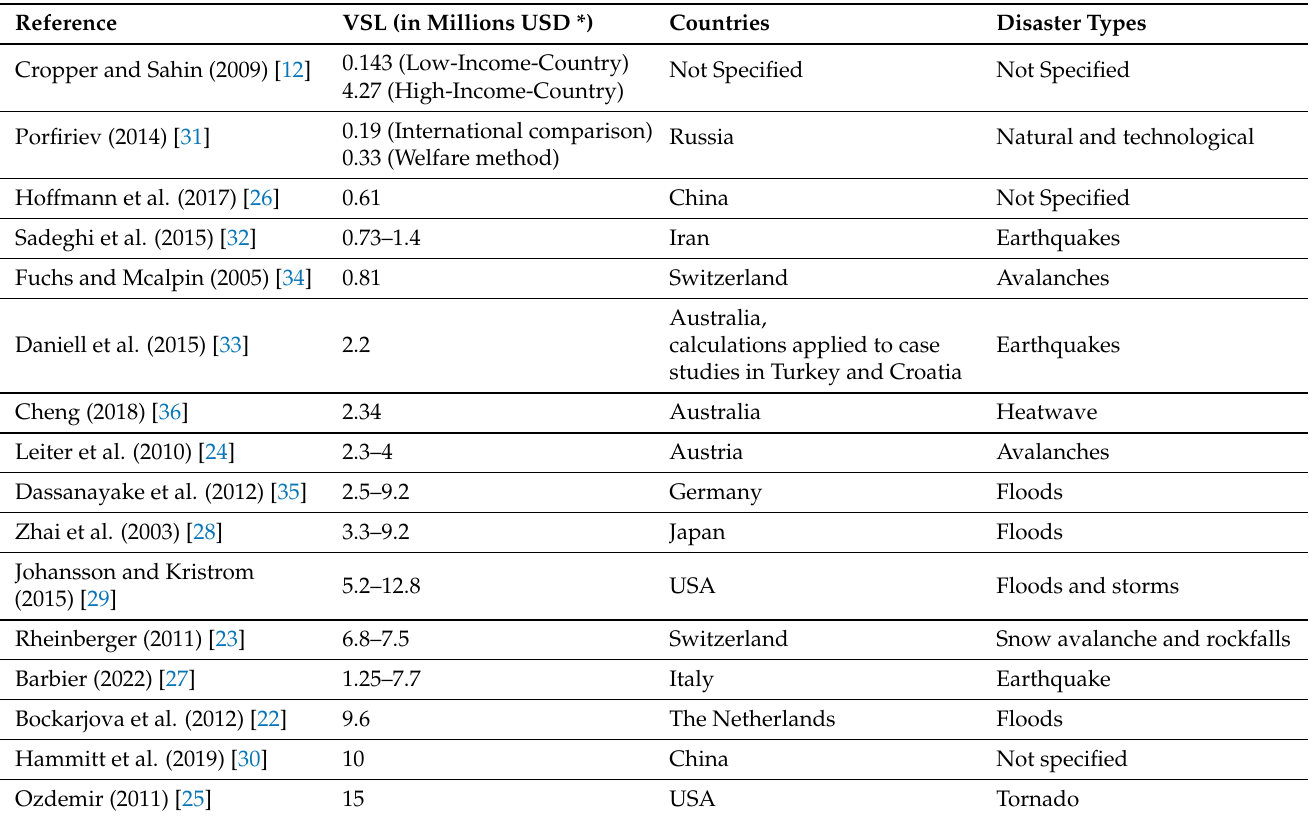
Table 2. Estimated values of statistical life in included